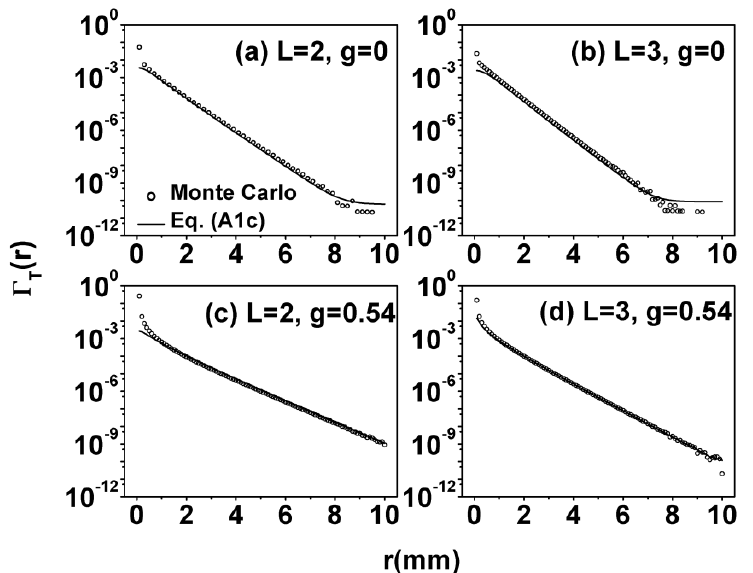
Figure 3. Comparison of the radial distribution of transmitted photons at small